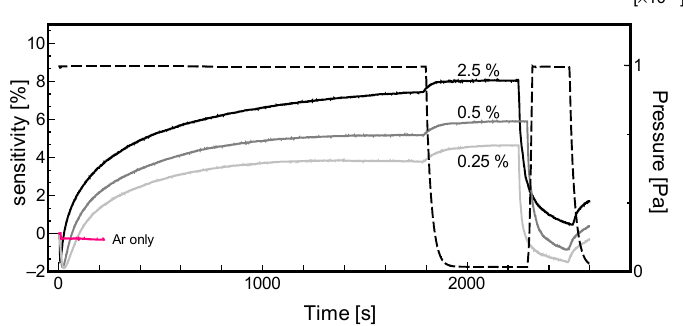
Figure 5. Effect of sensitivity of Sample 213-1 on hydrogen concentrations.